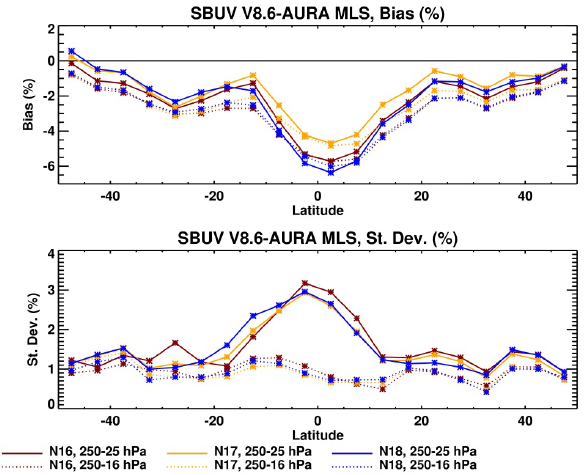
Fig. 9. Biases (top) and standard deviations (bottom) for N16, N17 and N18 relative to Aura MLS in the integrated ozone layers be- tween 250–25hPa (solid lines) and 250–16hPa (dotted lines) as a function of latitude.